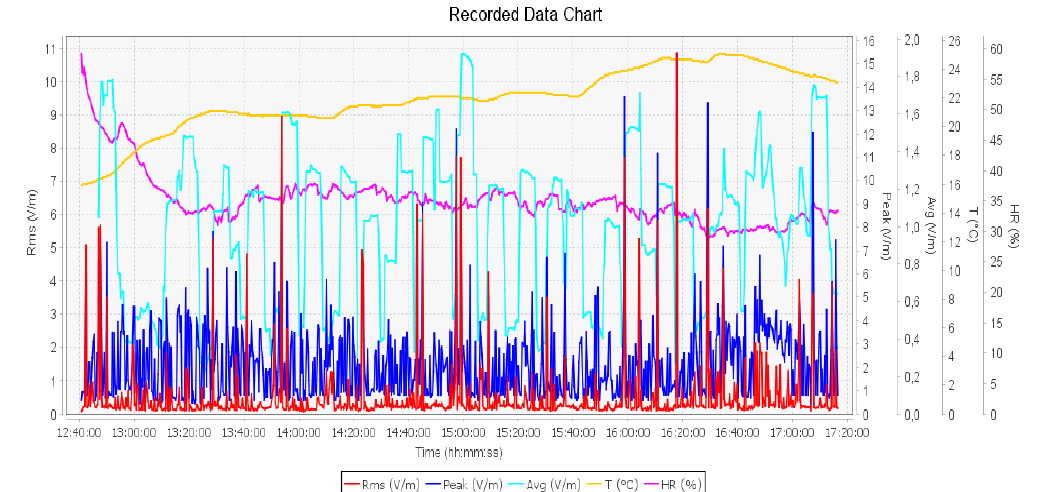
Figure 8. The intensity of the electrical component of the electromagnetic field in the course of flight no. 3 for the Cessna 172.